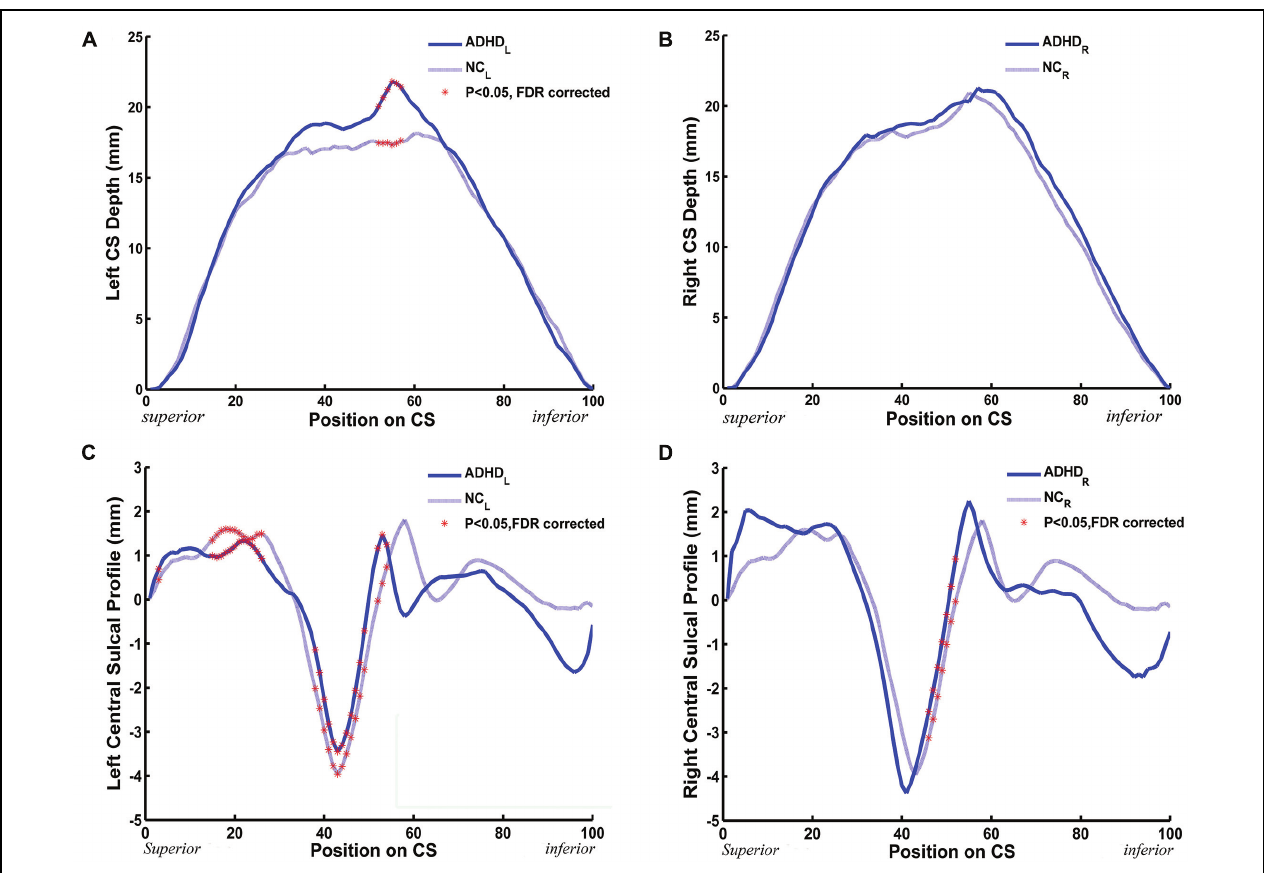
FIGURE 3 | The between-group (ADHD vs. NC) difference along the mean DPPs and the central sulcal profile curve. (A,B) The mean DPP across the children with ADHD (blue solid trace) and the mean DPP across the healthy children (blue dashed trace) were plotted by position. (C,D) The average central sulcal profile of the children with ADHD (blue solid trace) and the average central sulcal profile of the healthy children